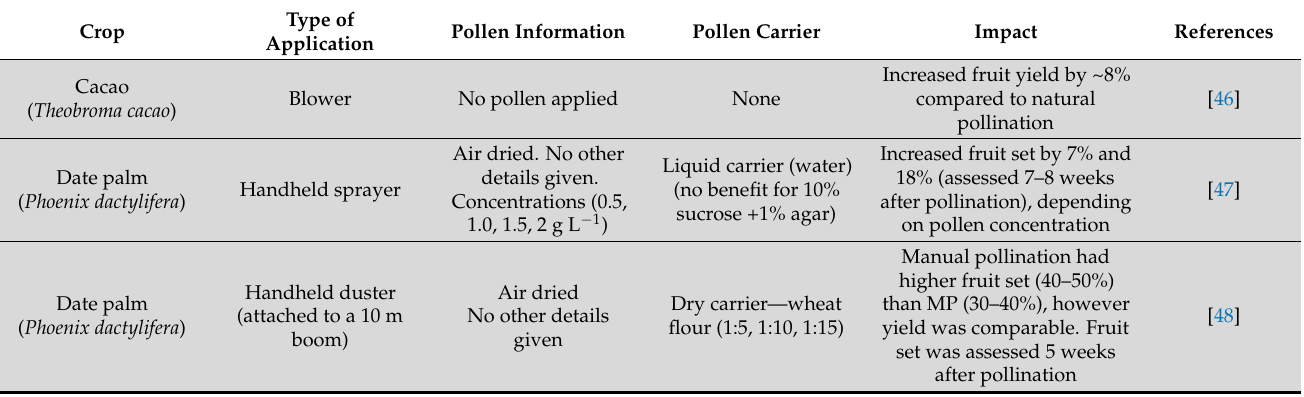
Table 2. Examples of mechanical pollination (MP) in fruit and nut crops published since 2008 (only includes studies that used processed pollen or mechanical equipment). * ‘grey’